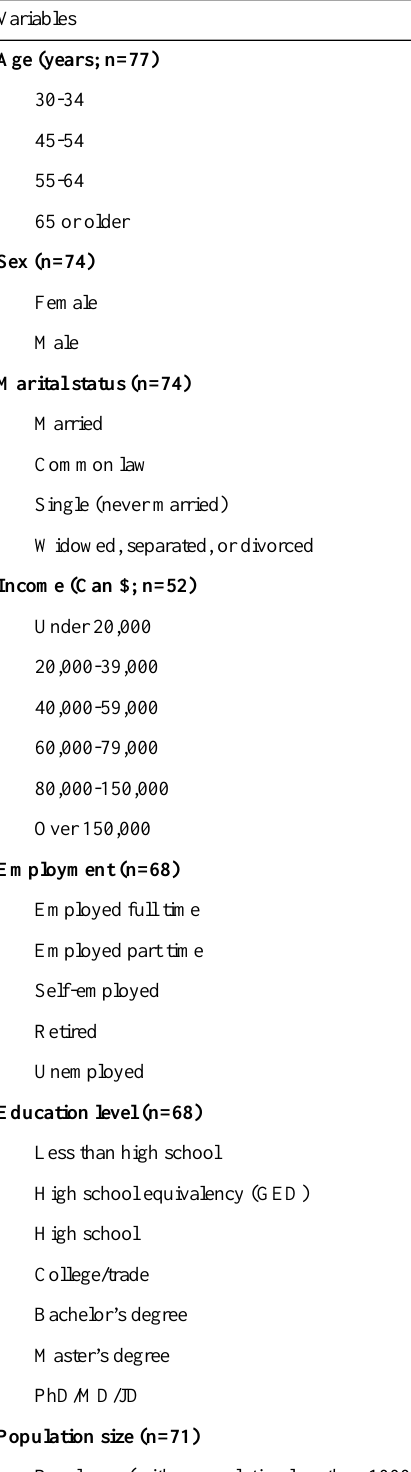
Table 1. Participant demographics and health information